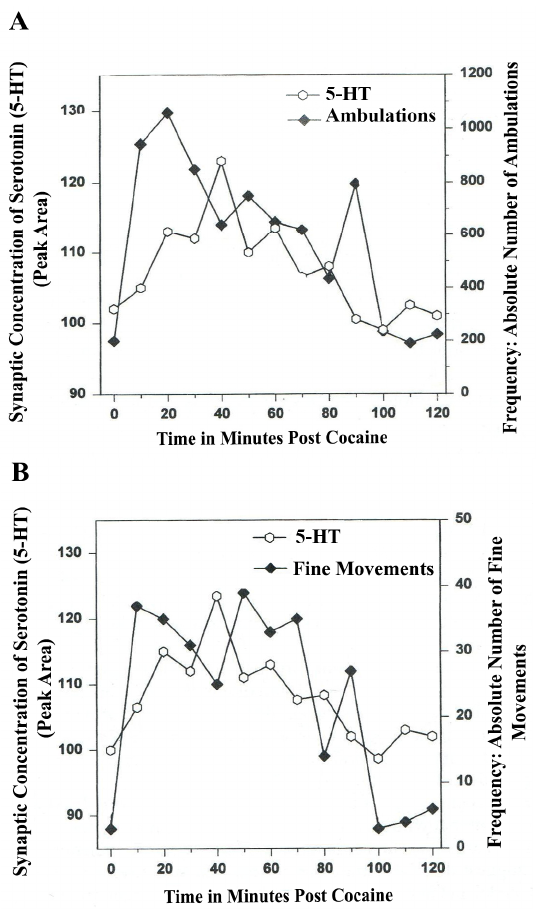
terminals , vlNAcc , in 10